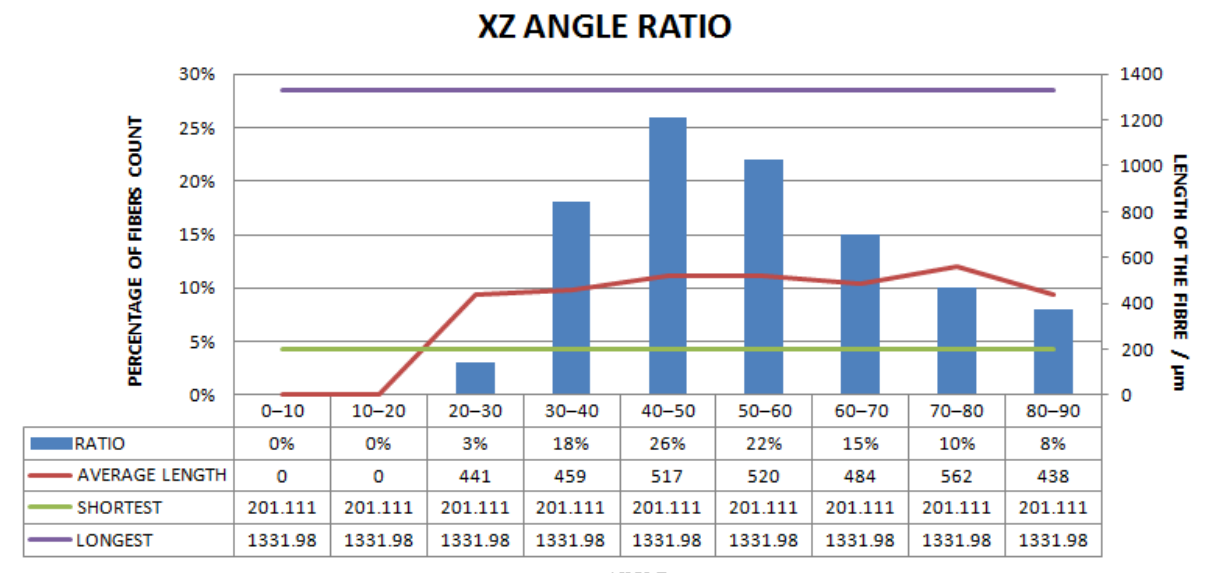
Figure 15. Statistical diagram of the angle between polyester short fibers reconstructed by Avizo software and the XZ direction (less than 200 microns removed).